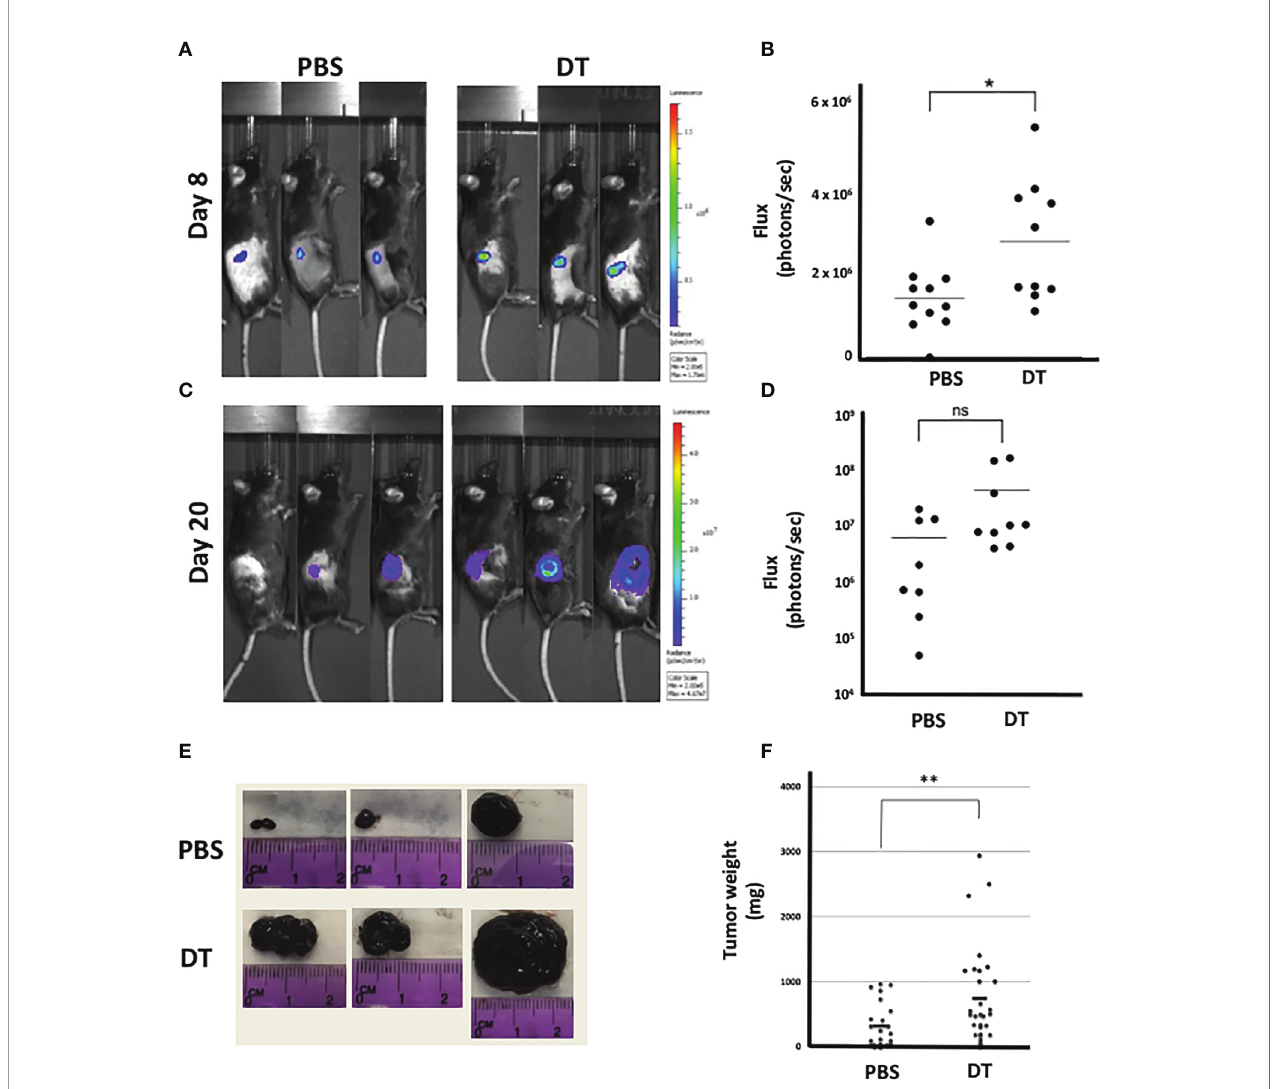
FIGURE 2 | Depletion of L2pB1 cells increases tumor mass. CD19-Cre-PZTD transgenic mice received daily intraperitoneal injection of PBS or diphtheria toxin (DT) for 4 days to deplete L2pB1 cells prior to subcutaneous inoculation with either luciferase-expressing (Luc-R) or WT B16F10 melanoma cells. Representative peak bioluminescent signal acquired by IVIS on (A) day 8 and (C) day 20 (n=9 PBS; n=10 DT). Bioluminescent fl ux quanti fi cation for (B) day 8 post-inoculation and (D) day 20 post-inoculation. (E) Gross observation of B16F10 melanoma tumor growth in representative PBS and DT-injected mice. (F) Comparison of end-point B16F10 tumor weights between PBS-injected (n=24) and DT-injected (n=29) mice. ns, not statistically signi fi cant; *P = 0.0212, **P = 0.0082. Data shown lare pooled from at least three independent